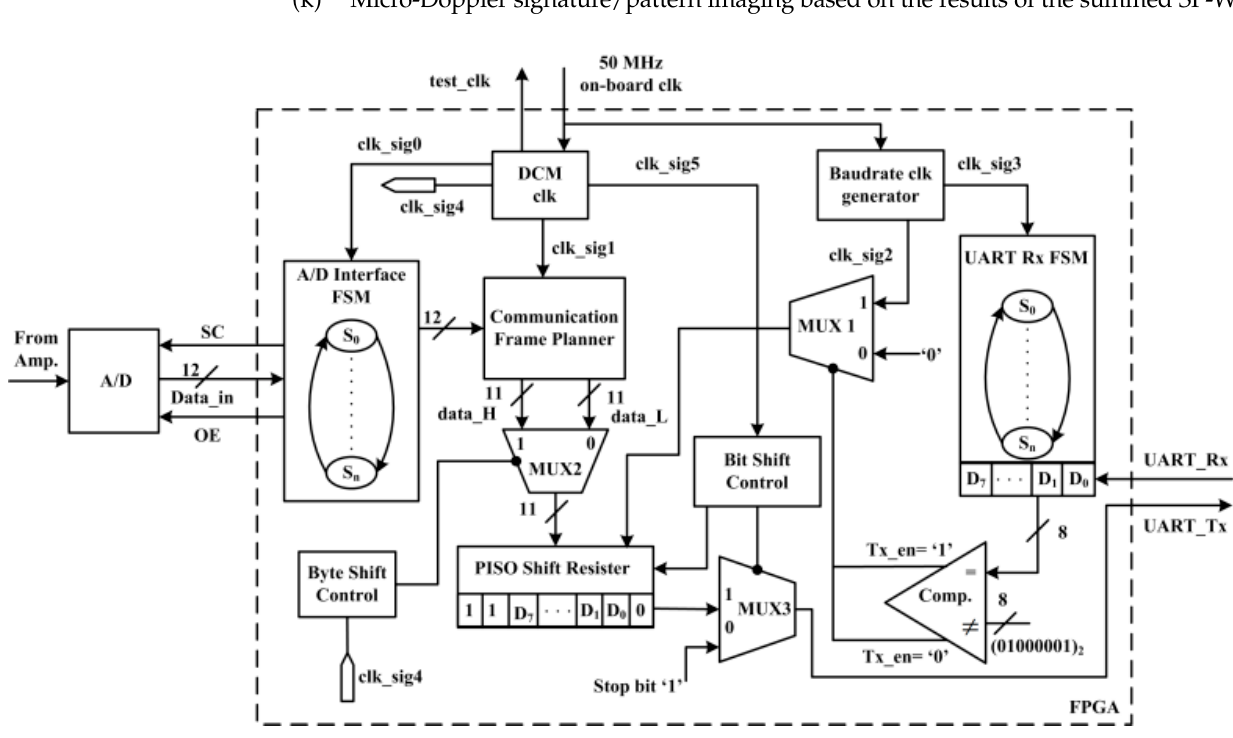
Figure 4. RF signal acquisition and preprocessing digital architecture built in the field-programable gate array (FPGA).